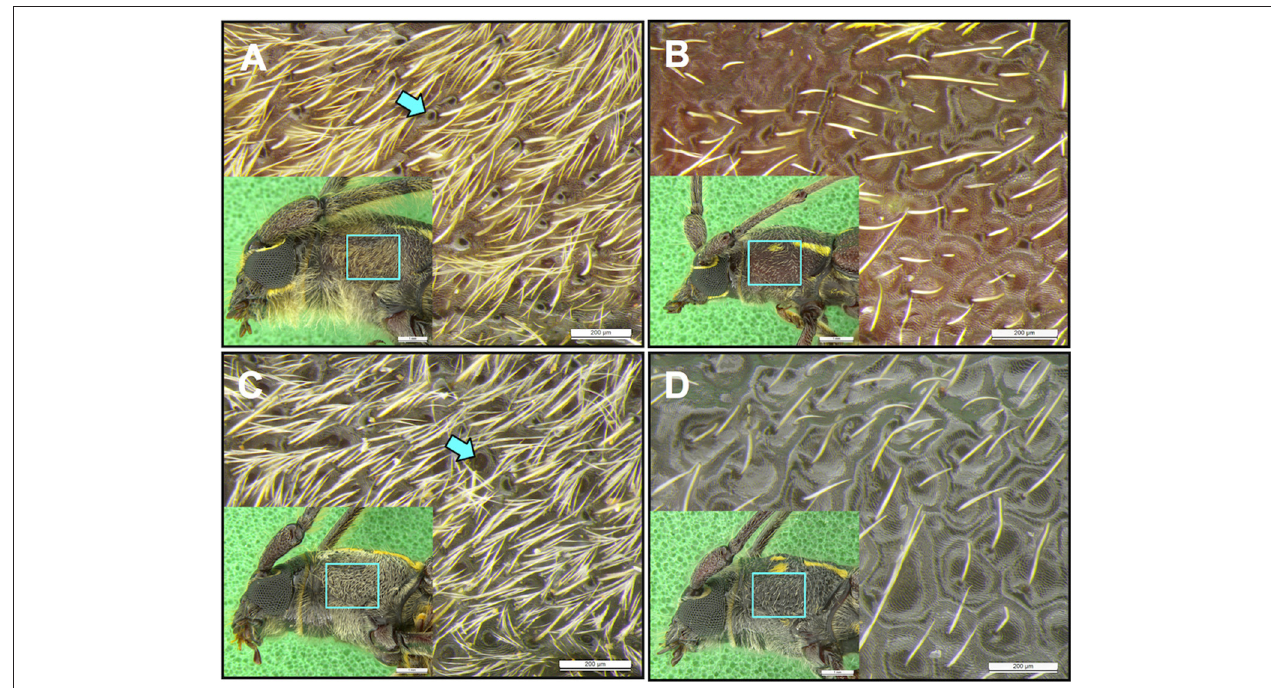
FIGURE 3 | Sexual dimorphism in pronotal pores in Ambonus distinctus and Ambonus electus . Close-up of the anterior corner of the tergum of (A) male and (B) female A. distinctus , and (C) male and (D) female A. electus . Males of both species have sex-specific pores (as shown by arrows) that are absent in females, and a higher density of